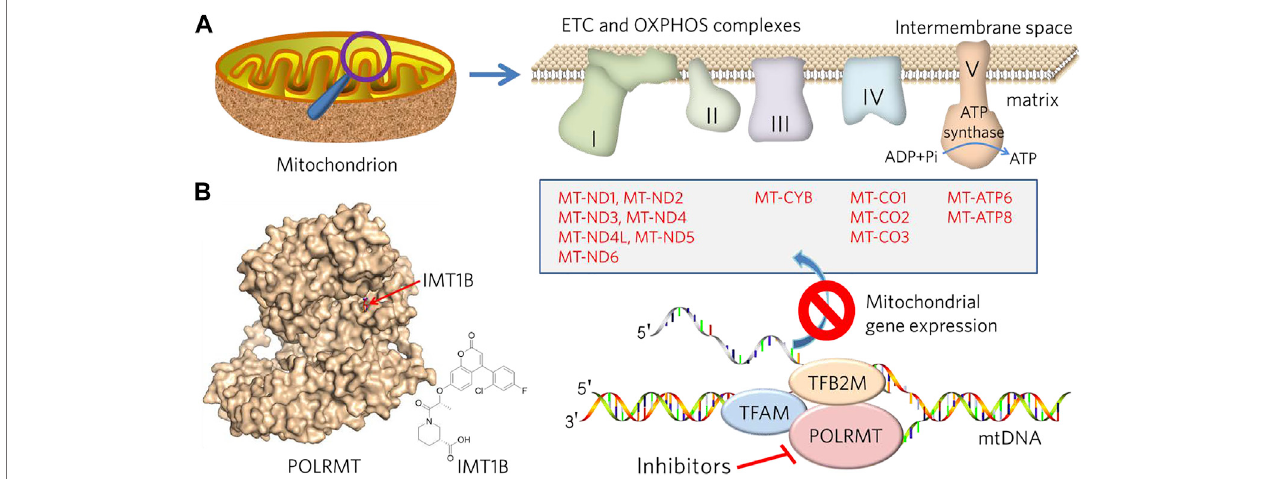
FIGURE 1 | Description of the design and rationale for overcoming MDR by targeting mitochondrial metabolism and mtDNA transcription. (A) Mitochondria are bilayer membranous organelles. OXPHOS consists of protein complexes located within the innermembrane, of which 13 protein components (list in box) belong to complexes I, III, IV and V, respectively, encoded by the mitochondrial genome and transcribed by POLRMT. Inhibition of POLRMT is thought to shut down the protein source of the OXPHOS system, which may lead to malfunction of the mitochondrial electron transport chain (ETC) and OXPHOS and a subsequent energy crisis. (B) POLRMT and its small chemical inhibitor, IMT1B (from PDB: 7A8P).